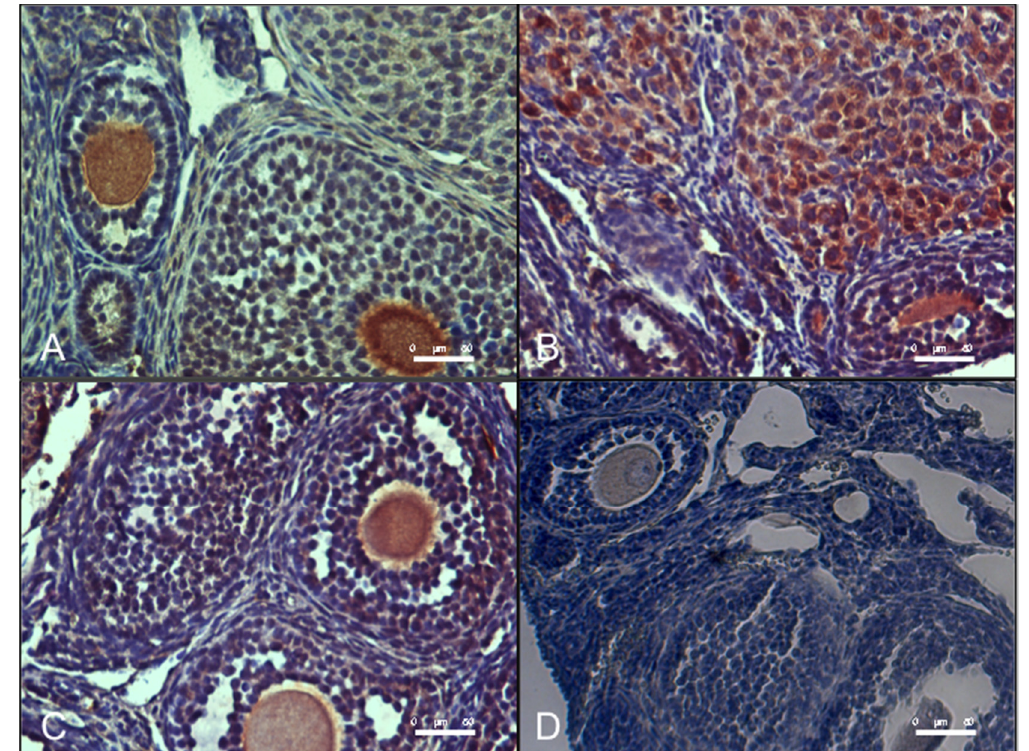
Figure 6. Oral administration of carnitine formulation 2 prevents the accumulation of methylglyoxal-advanced glycation end-products (MG-AGE) induced DHEA. Part of paraffin embedded sections of formalin-fixed ovarian tissue were processed immunohistochemical analysis of MG-AGE accumulation. Representative images of immunolocalization of MG-AGE in CTRL ( A ), DHEA ( B ), DHEA + C1 ( C ) and DHEA + C2 ( D ) ovaries are shown.